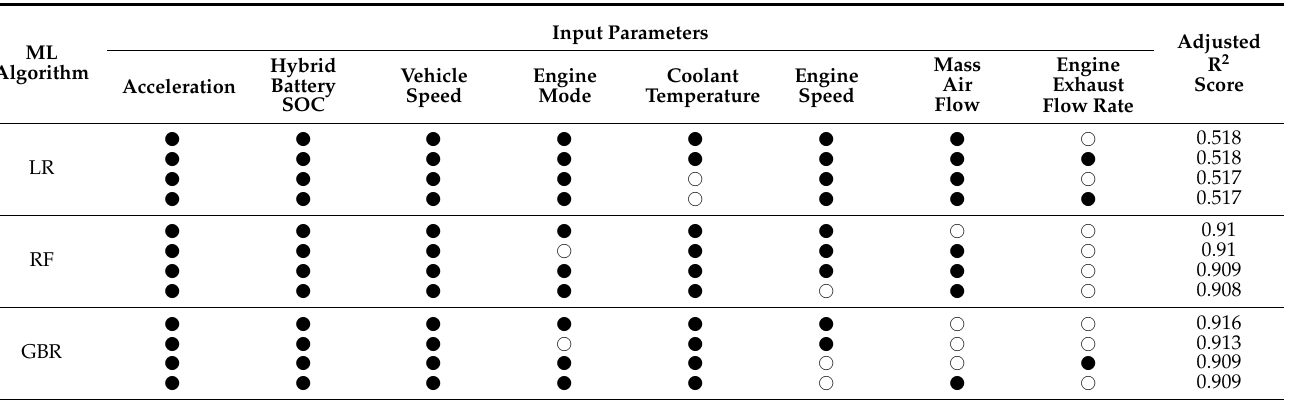
Table 3. Top 4 most accurate combinations of different input parameters with three traditional ML algorithms. The black dots indicate that the parameter was included in the input parameter for that combination, whereas the white dots indicate the